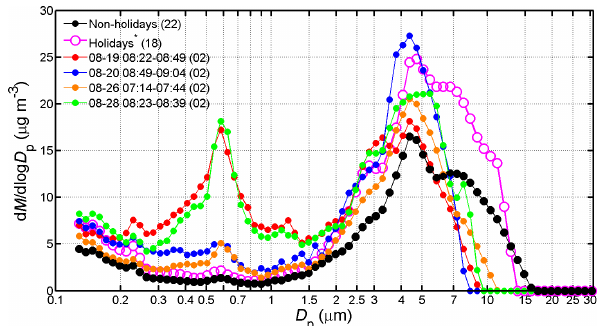
Figure 6. Average PMSDs within 50m above the ground for dif- ferent cases, with the same markers and text as in Fig. 5.